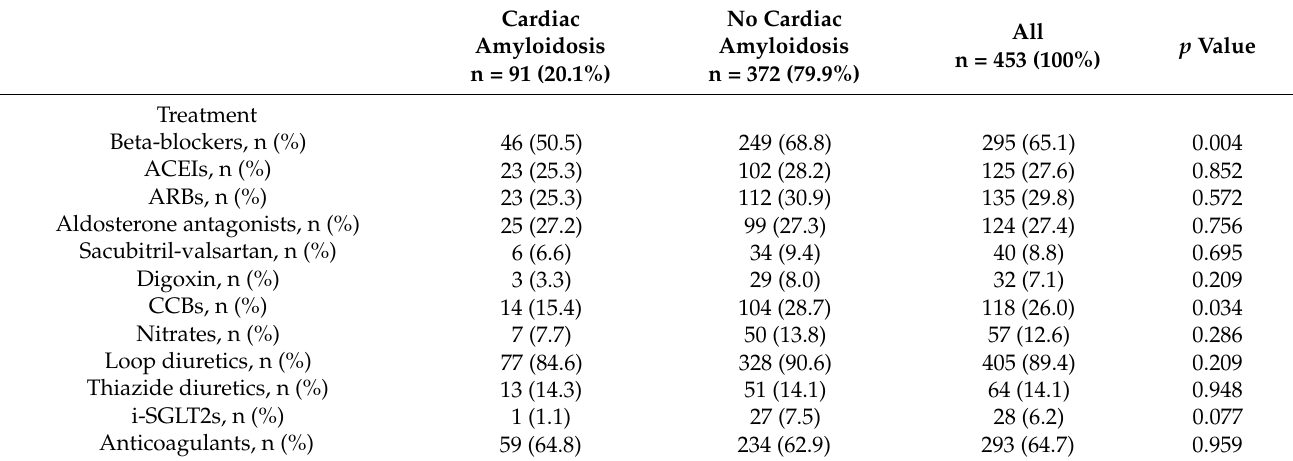
Table 1. Cont . Table 1. Baseline characteristics of the population. Table 1. Baseline characteristics of the population. Table 1. Baseline characteristics of the population. Table 1. Baseline characteristics of the population.